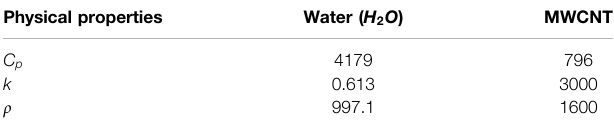
TABLE 1 | Thermophysical properties of nano fl uid. Physical properties